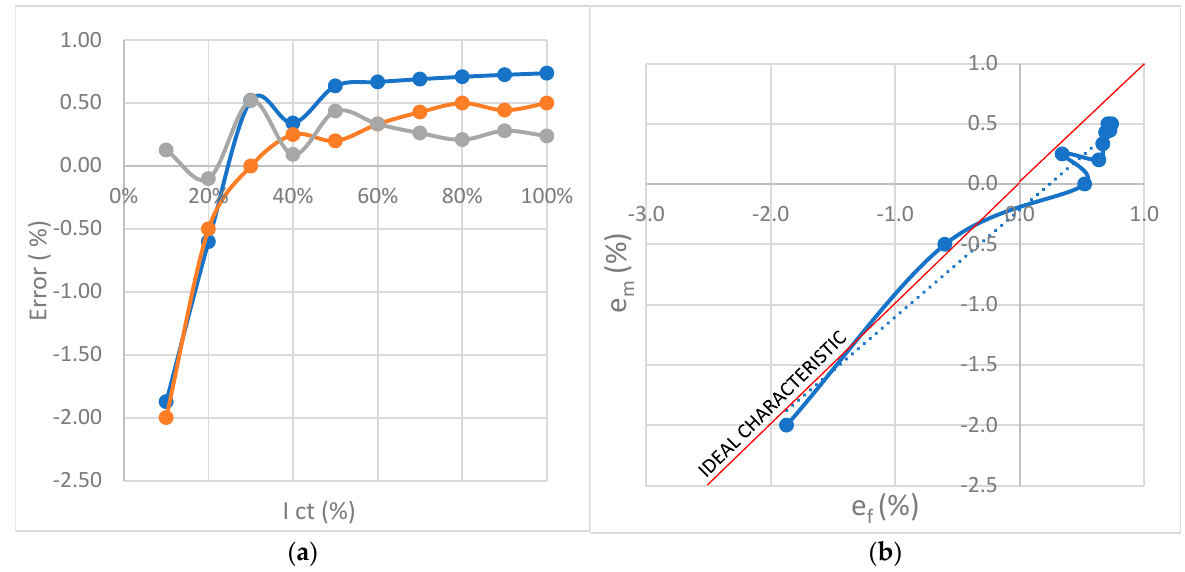
Figure 12. CT error depending on the secondary current for a temperature of 26.3 °C, f = 50 Hz. ( a ) measured (red); function (blue); difference (gray). ( b ) “Spline” curve of function error e f and measured error e m ; R 2 = 0.9624.